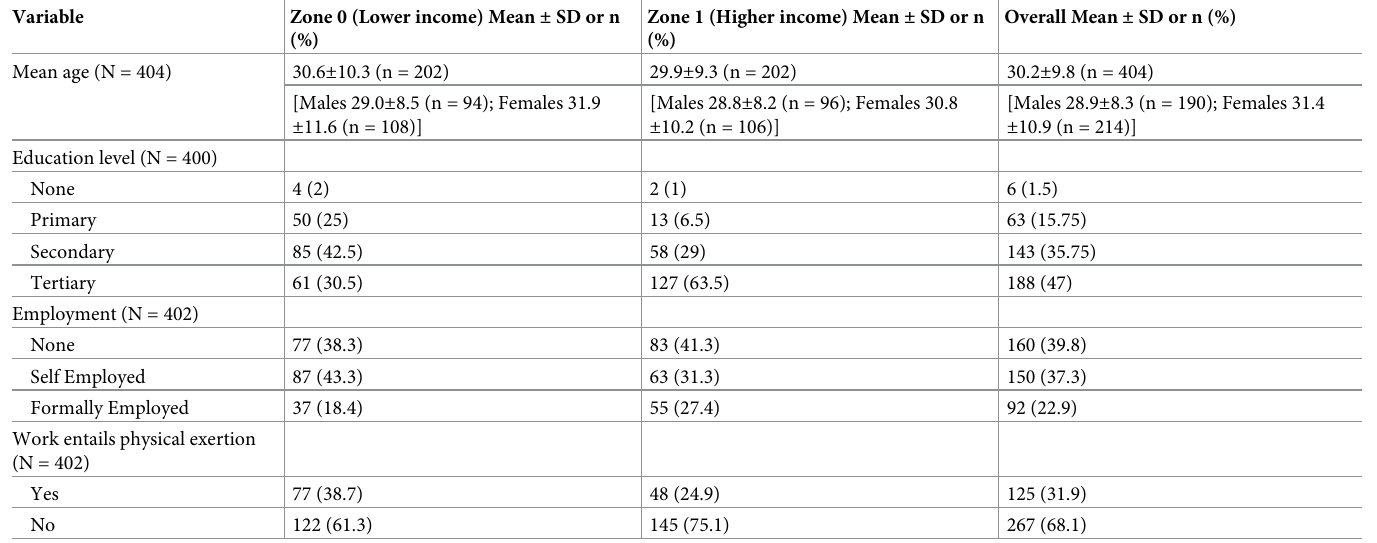
Table 1. Demographic